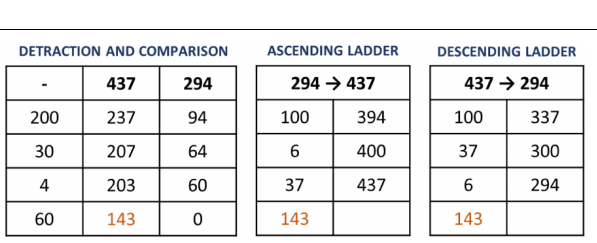
FIGURE 9 | Three subtraction formats in Open Algorithm Based on Numbers method: detraction and comparison, ascending ladder and descending ladder.